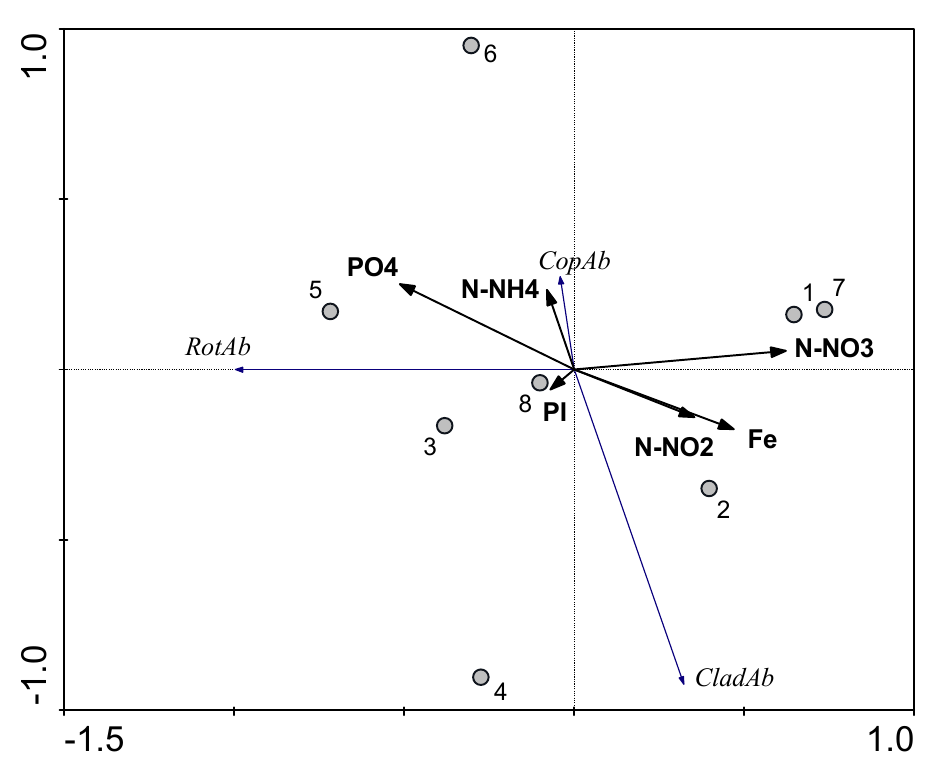
Figure 5. Redundancy analysis (RDA) ordination plot of environmental and quantitative variables of zooplankton of the Borovoe Lake, 2019. Circles − stations, blue arrows − biological variables, black arrows − environmental variables. Abbreviations used in the figure: RotAb − abundance of Rotifera , CladAb − abundance of Cladocera , CopAb − abundance of Copepoda, and TotAb − total zooplankton abundance.